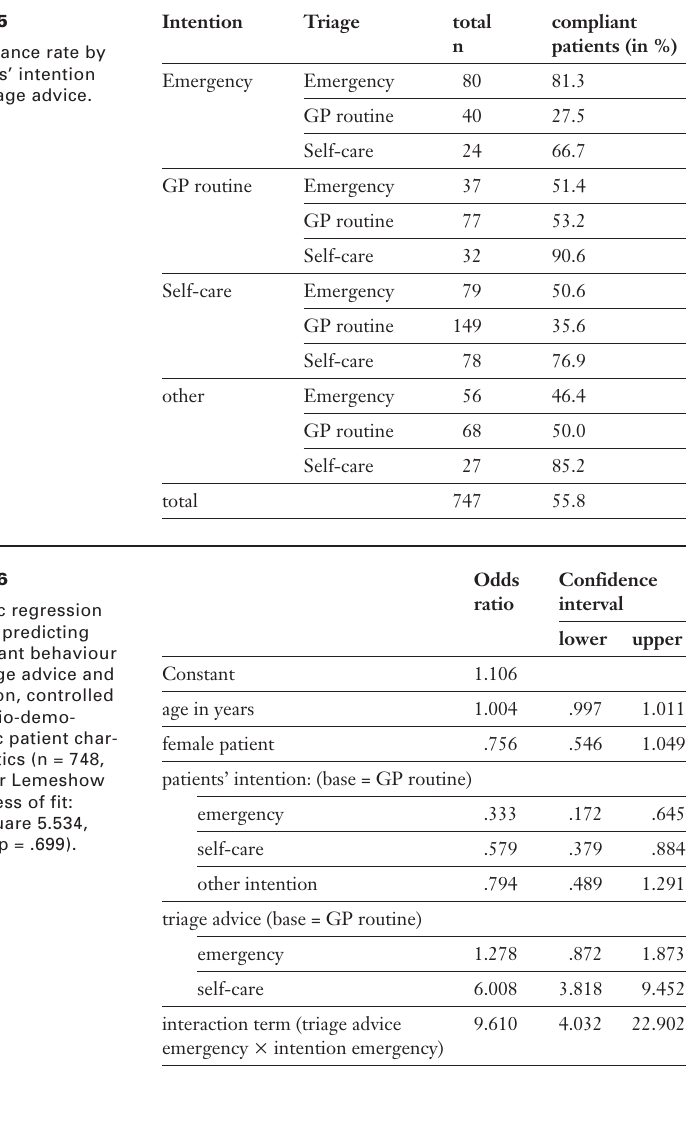
Compliance rate by patients’ intention and triage advice.